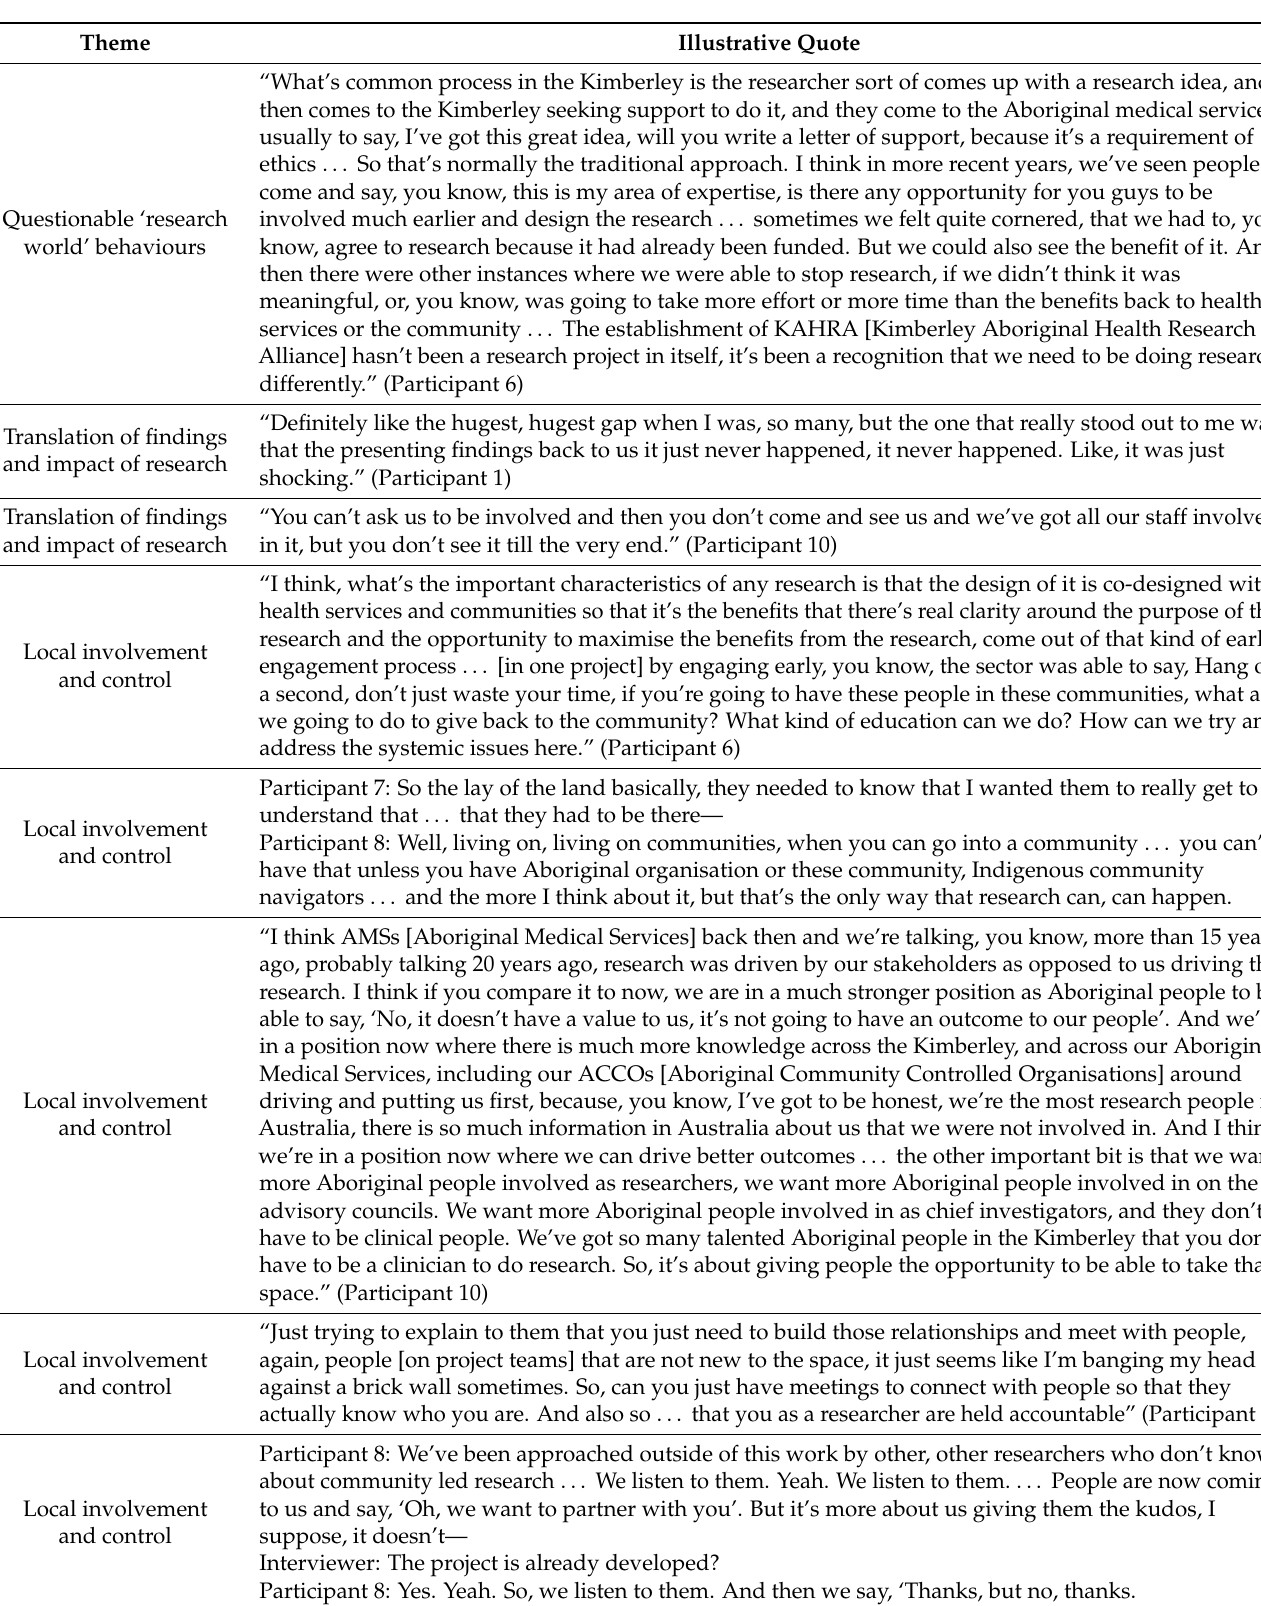
Table A2. Additional quotes from